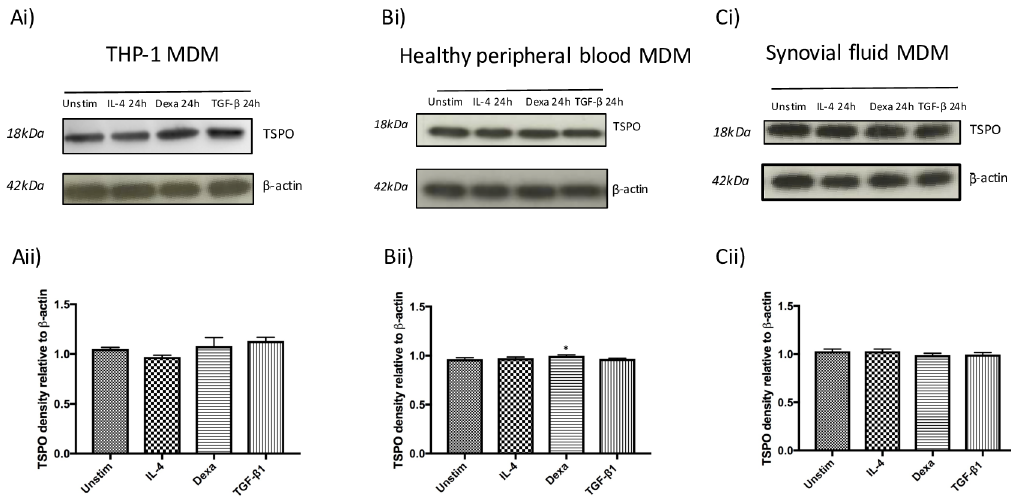
Fig 7. Western blotting indicates TSPO protein expression is largely unchanged in MDM treated with M2 stimuli. (i) representative Western blots of TSPO protein with β -actinacting as loadingcontrol and (ii) densitometry normalized to β -actin in (A) THP-1 MDM, (B) healthy peripheral blood MDM and (C) synovialfluid MDM either unstimulated ( Unstim ) treated with 20ng/mLIL-4, 500nMdexamethasone or 3ng/mL TGF- β 1 for 24 hours. Densitometry data is expressed as the mean of five independent experiments ± SEM. ( * p < 0.05, ** p < 0.01, *** p (cid:20) 0.001).